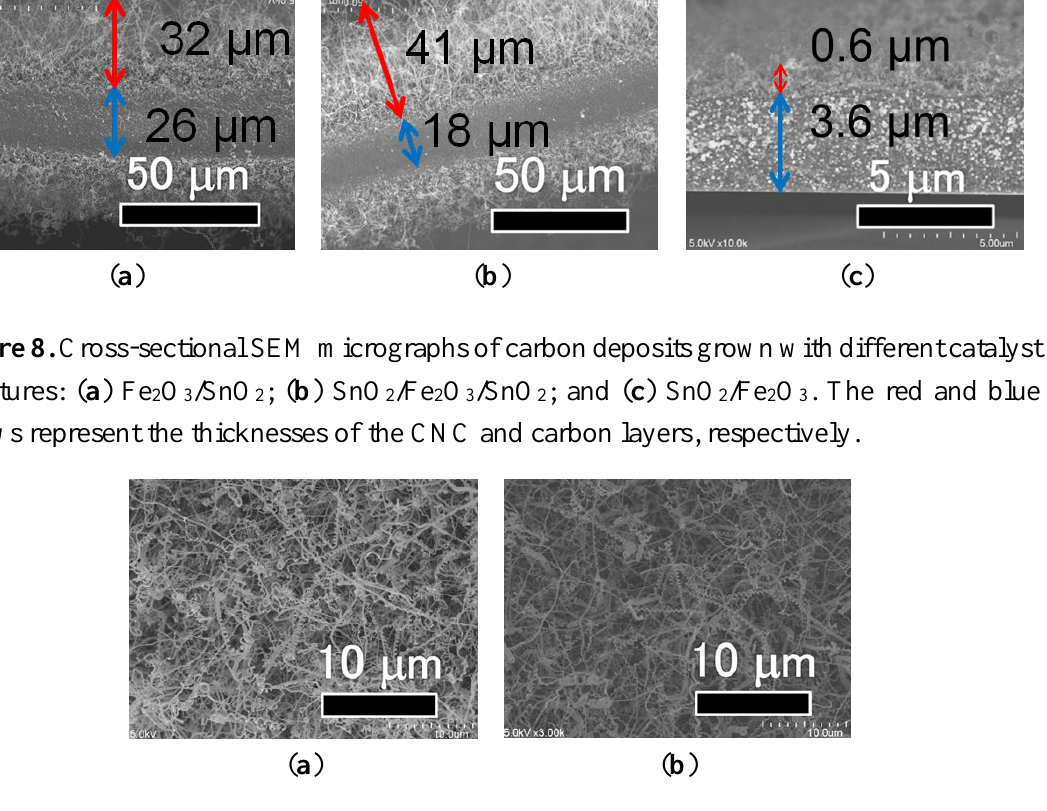
Figure 9. SEM micrographs of the surfaces of CNC layers grown from different catalyst structures: ( a ) Fe 2 O 3 /SnO 2 and ( b ) SnO 2 /Fe 2 O 3 /SnO 2 . No CNCs were observed on the SnO 2 /Fe 2 O 3 catalyst